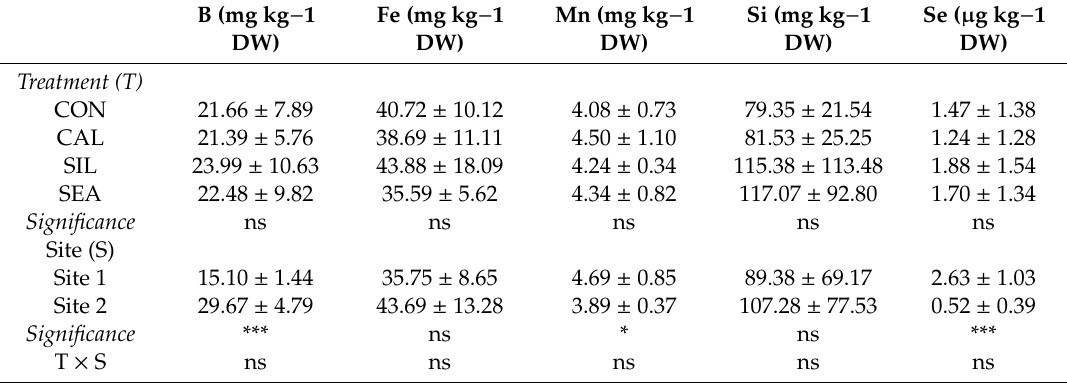
Table 6. Micronutrients content in apple skin at harvest as a ff ected by treatments and sites 1